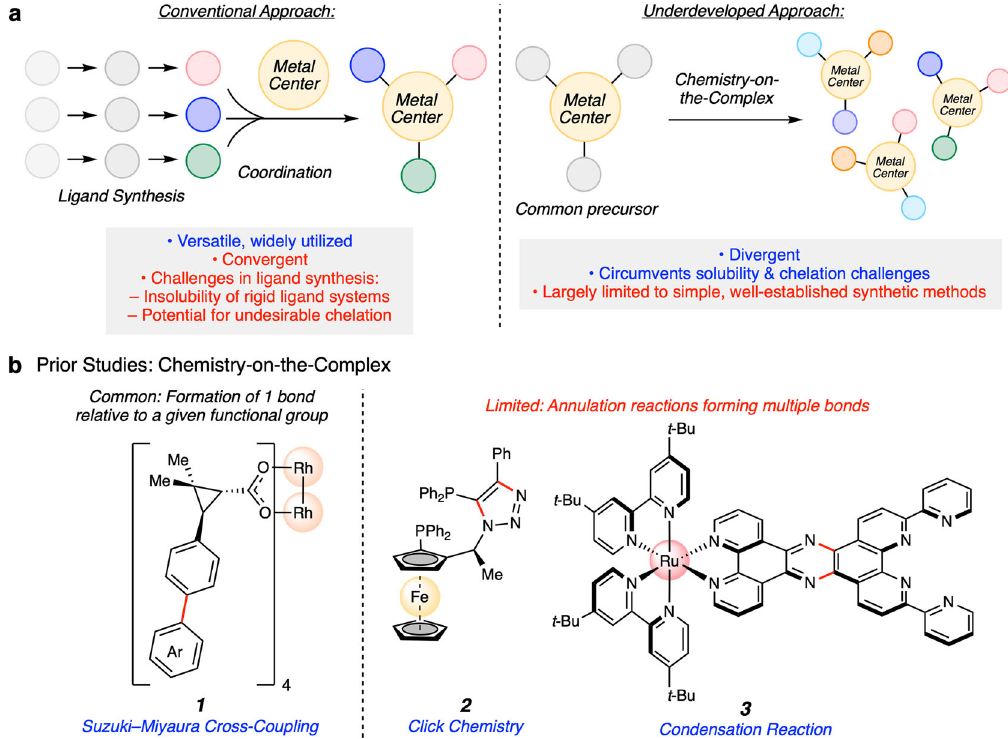
Fig. 1 General synthetic approaches toward metal – ligand complexes. a Comparison of coordination chemistry and chemistry-on-the-complex. b Prior studies involving chemistry-on-the-complex. Me, methyl; Ph, phenyl; t -Bu, tert